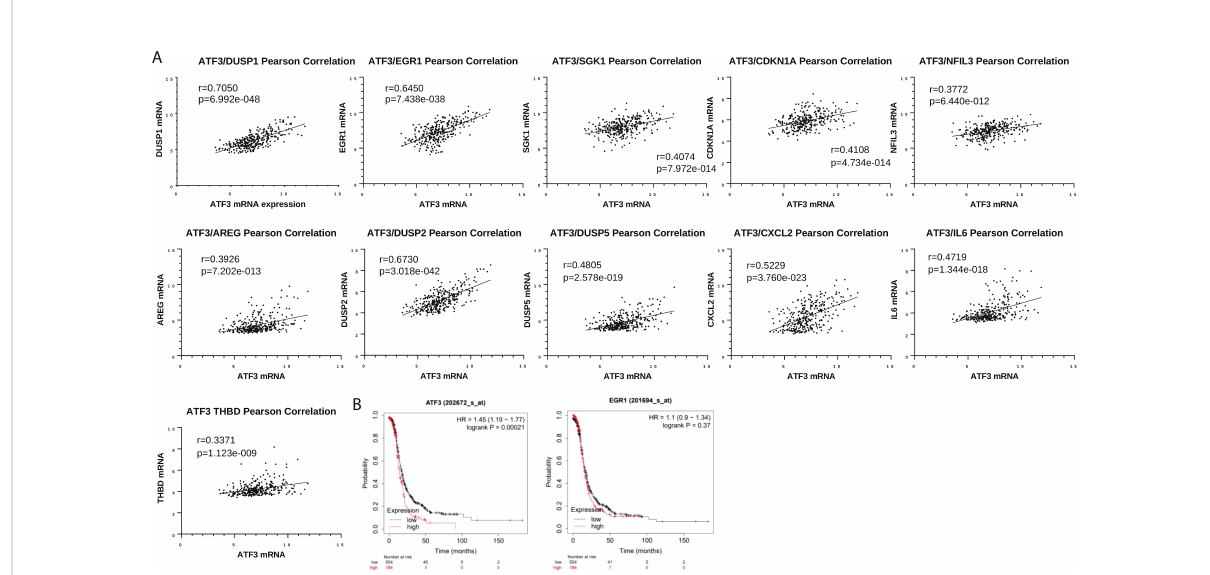
FIGURE 6 Top differentially expressed genes are associated with each other in The Cancer Genome Atlas (TCGA) but have differential relationships with patient progression free survival (PFS). (A) Pearson correlation between ATF3 and DUSP1, EGR1, SGK1, CDKN1A, NFIL3, AREG, DUSP2, DUSP5, CXCL2, IL6 , and THBD in cBioPortal TCGA Firehose Legacy ovarian cancer dataset (microarray U133 data, n=310). (B) Kaplan-Meier curves for ATF3 and EGR1 and PFS in Stage III-IV, grade 3 HGSOC, using top quartile cutoff (all datasets at kmplot.com).